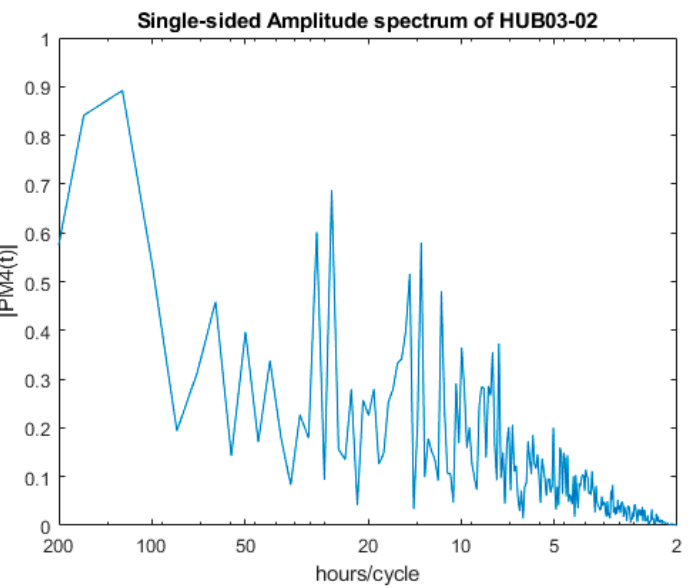
Figure 15. Fourier transform analysis of valve openings of mollusc HUB03-02 in the second study group, from 5 to 28 July 2018 (x-axis in semi-logarithmic scale). Table 2. Dominant periods (hours/cycles) in descending order from the 1 st to the 6 th for HUB03-01 and HUB03-02.